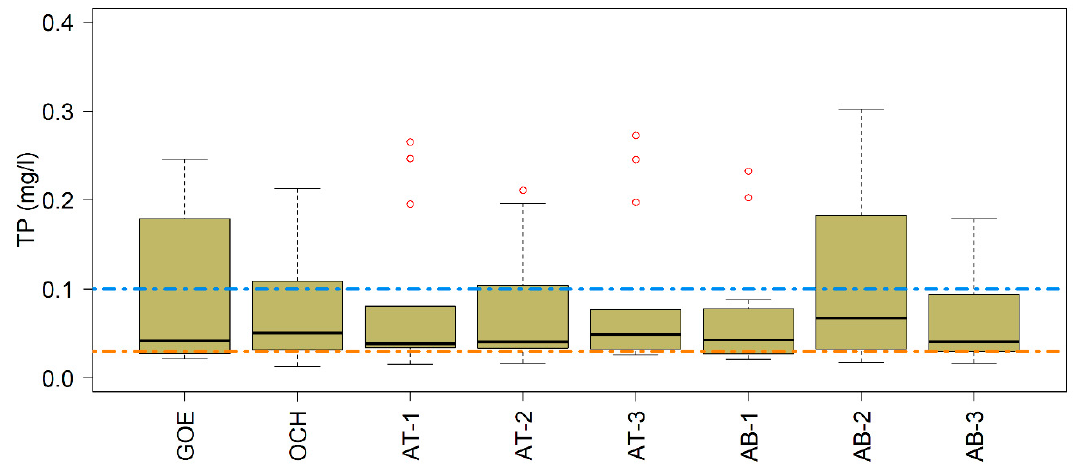
Figure 7. Total phosphorus (TP) concentration during the investigation period, according to sampling stations (n = 14 per station). Dashed lines represent thresholds of nutritional status according to OGewV (2016): orange line = threshold between good (<0.03 mg TP/l) and moderate ecological status (>0.03 mg TP/l); blue line = threshold between moderate and poor ecological status (>0.1 mg TP/l).